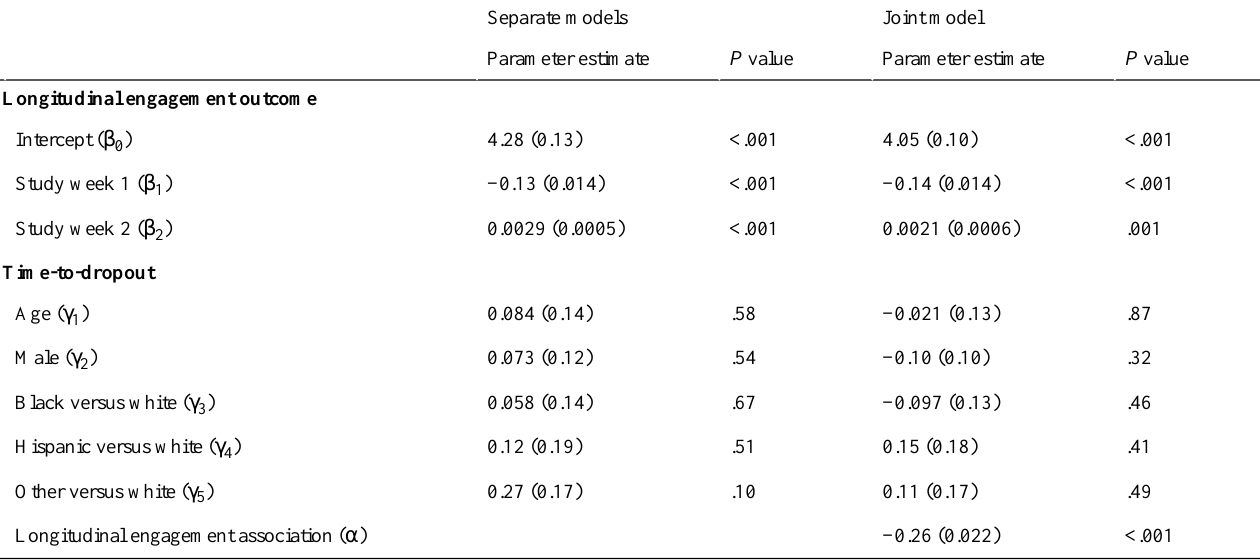
Table 1. Model results from separate models of engagement with an mHealth intervention (defined as intervention use) and time to dropout and the joint model of engagement and time to